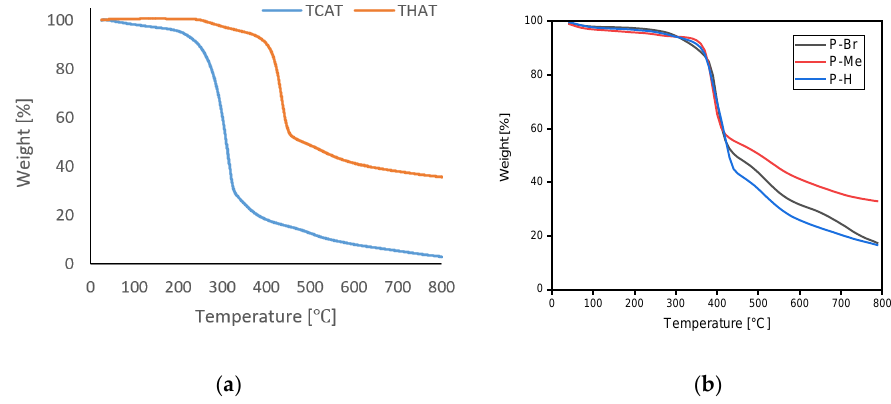
Figure 2. Thermogravimetric Analysis (TGA) degradation curves for ( a ) TCAT, THAT; ( b ) TBAT (p-Br), TAT(p-H), TMAT (p-MeO) derivatives.